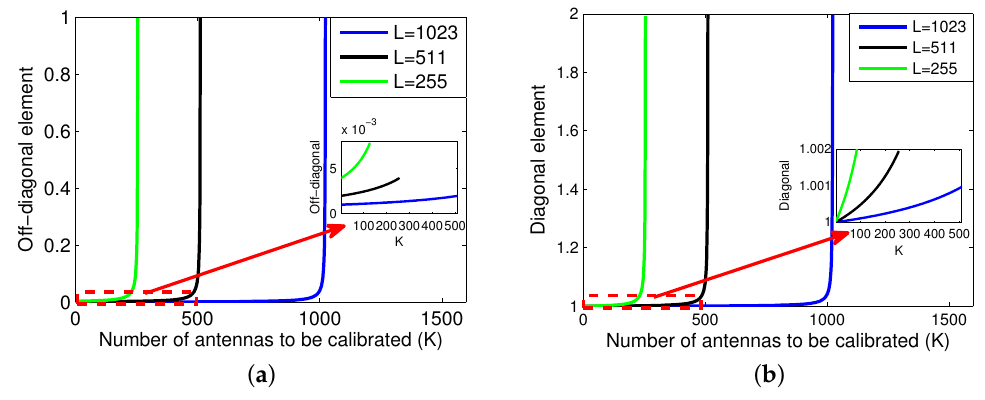
Figure 5. The elements of the matrix M − 1 versus K . ( a ) The off-diagonal element of M − 1 . ( b ) The diagonal element of M − 1